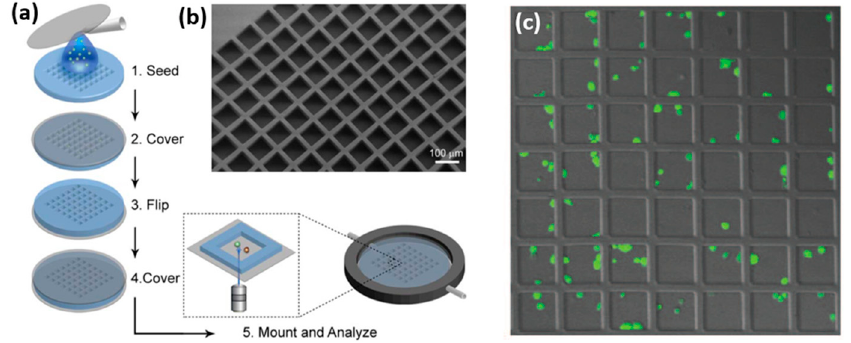
Figure 7. Chip with microwells for confinement. ( a ) Chip fabrication. ( b ) Scanning electron microscope of the chip structure. ( c ) NK cells within the chip after 2 h of incubation. Reproduced from Reference [55].